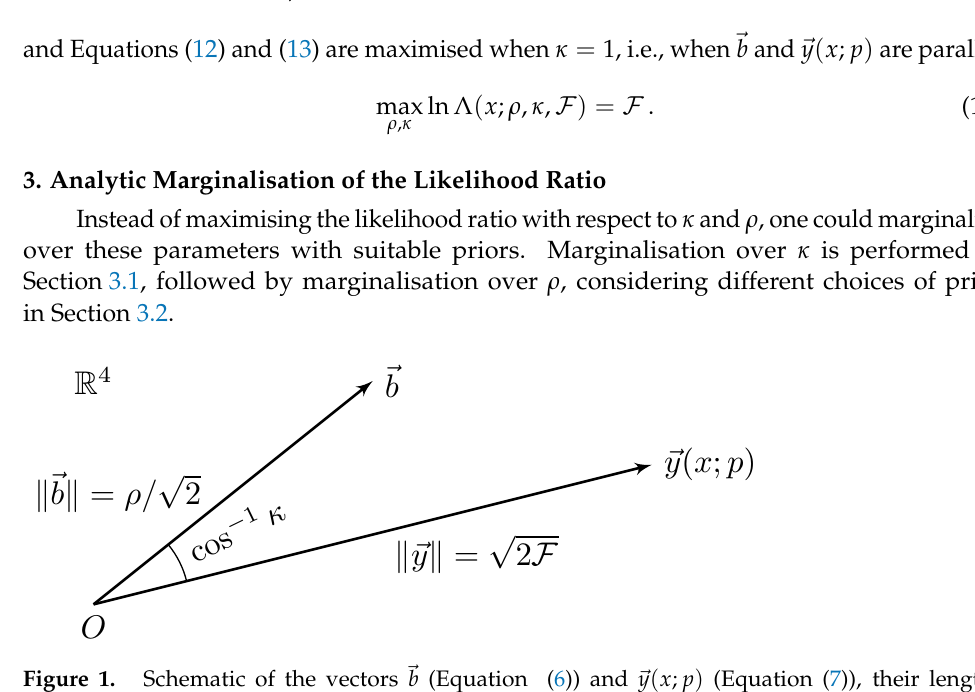
Figure 1. Schematic of the vectors (cid:126) b (Equation (6)) and (cid:126) y ( x ; p ) (Equation (7)), their lengths (Equations (9) and (10)), and the cosine κ of the angle between them (Equation